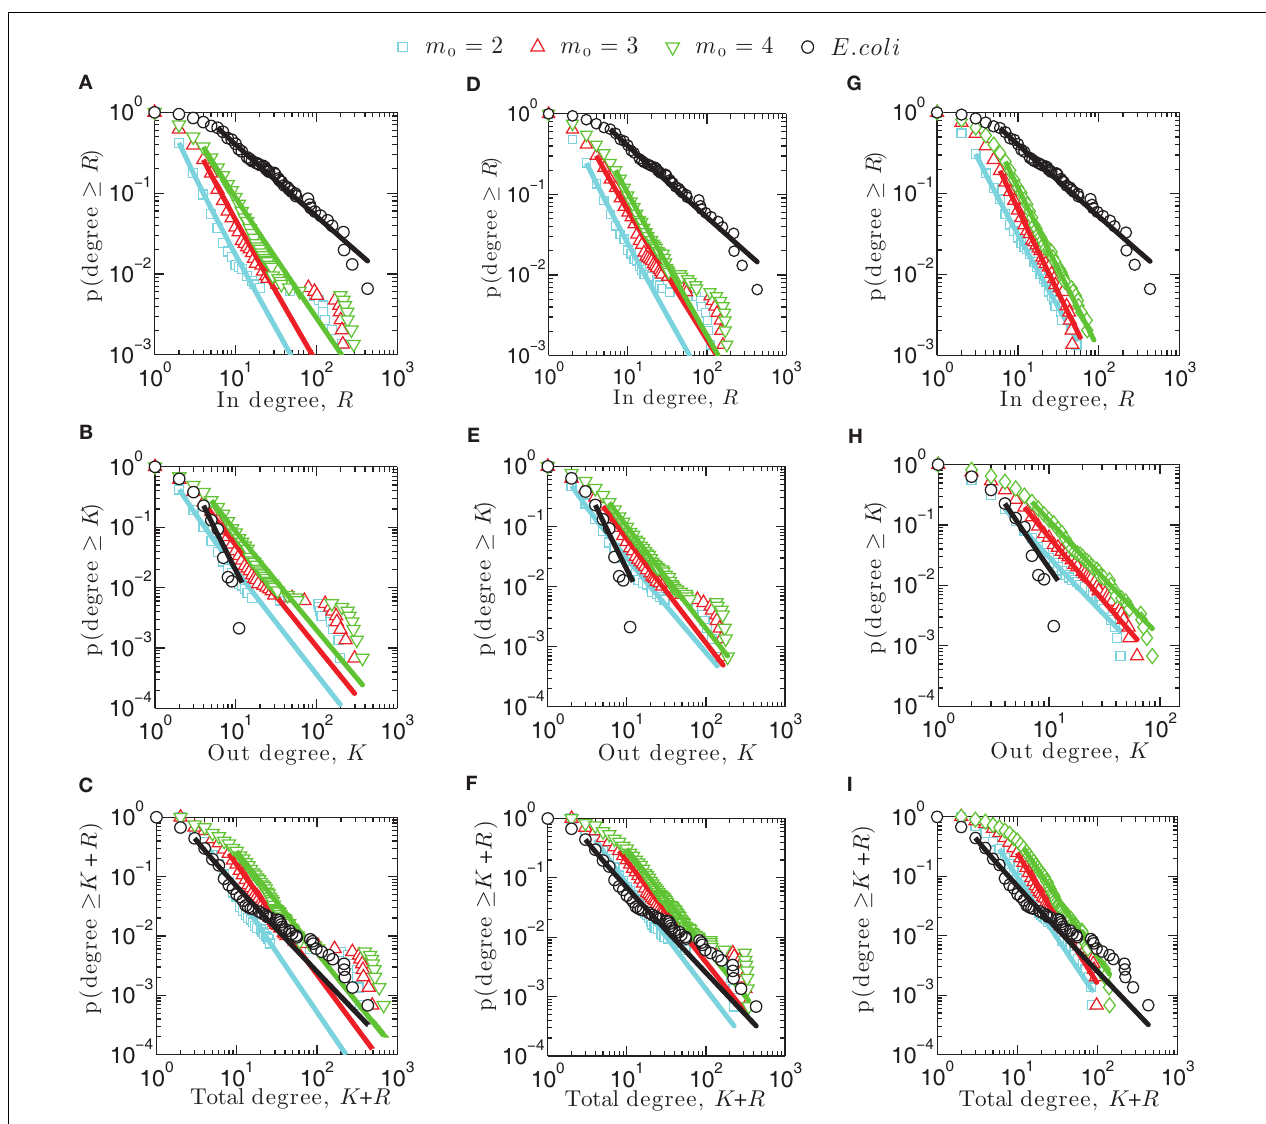
FIGURE 2 | Cumulative degree distributions for synthetic networks created using linear attachment kernels (A–C), power-law kernels (D–F), and sigmoidal type kernels (G–I).